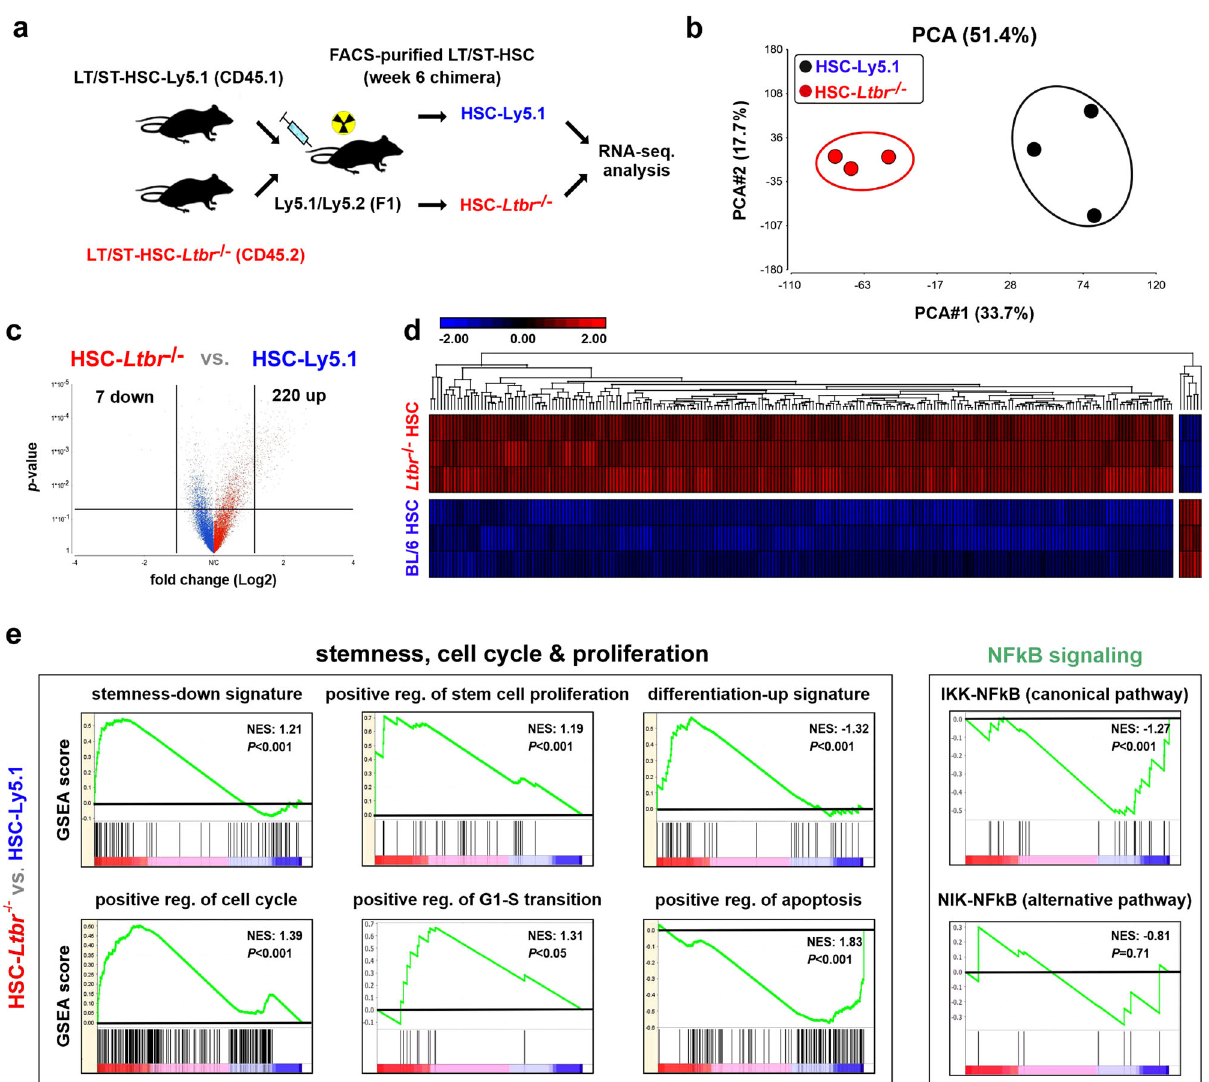
Fig. 3 Loss of LT β R leads to a higher expression of genes related to cell cycling and survival while reducing the expression of genes de fi ning stemness. a Experimental setting. FACS-puri fi ed Ltbr − / − and Ly5.1 LT/ST-HSCS from chimeras 6 weeks after primary transplantation ( n = 6, pooled to three biological replicates) were used for RNA-seq analysis. b PCA with samples plotted using the 1st two principal components. c Volcano plot of differentially regulated genes. d Hierarchical clustering. e Gene set enrichment analysis (GSEA, pathcards.genecards.org)